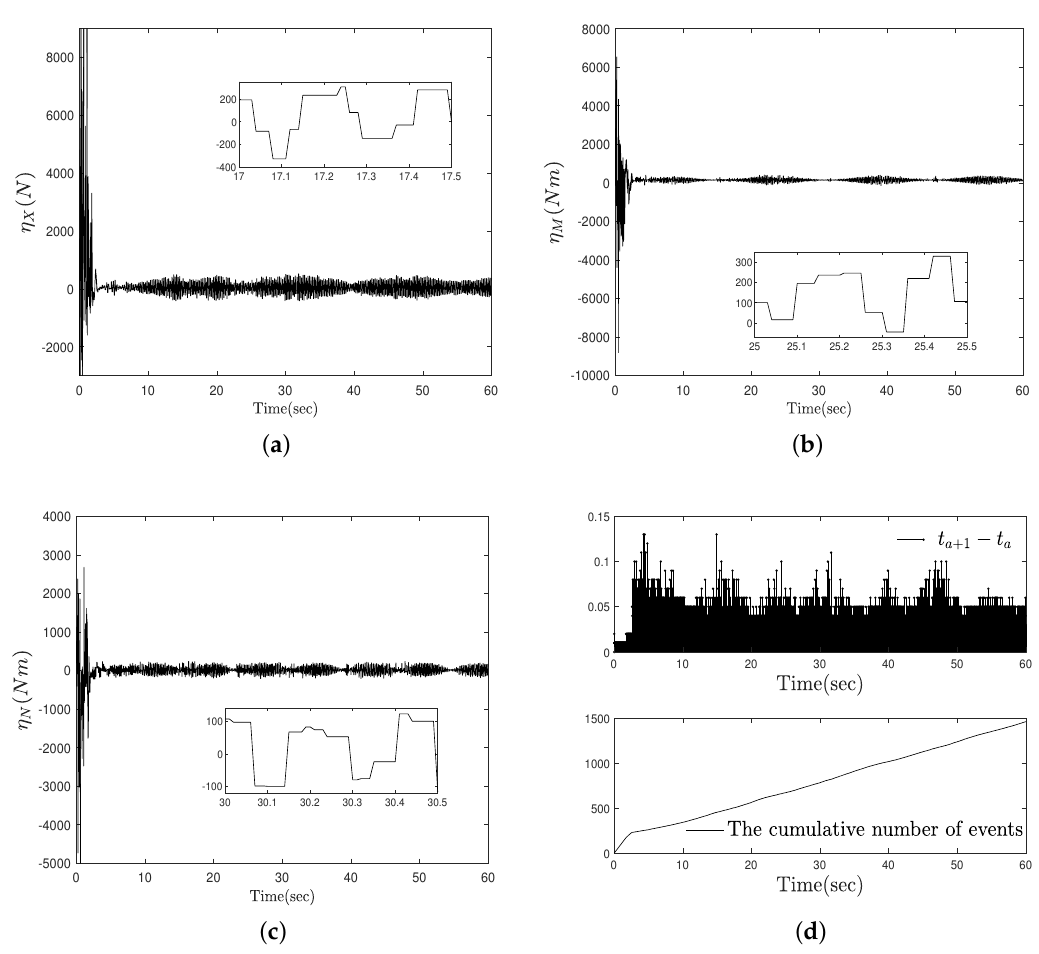
Figure 13. Event-driven control laws, inter-event times, and the cumulative number of events of the proposed approach for Scenario 2 ( a ) η X ( b ) η M ( c ) η N ( d ) inter-event times and the cumulative number of